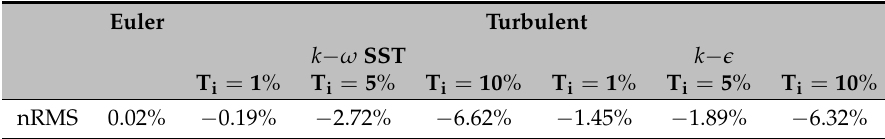
Figure 7. Time trace of the free surface elevation measured at the intended device location during wave-only tests. Table 3. nRMS between the different viscous and inviscid flow simulations for the wave-only test